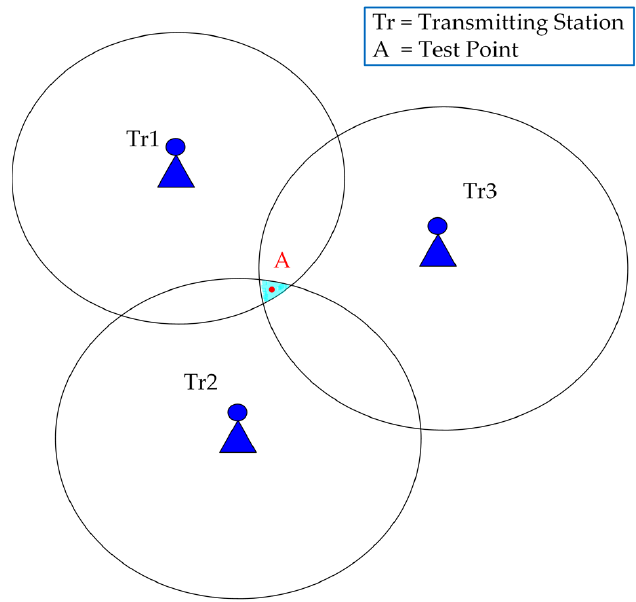
Figure 3. eLoran pseudorange positioning principle.